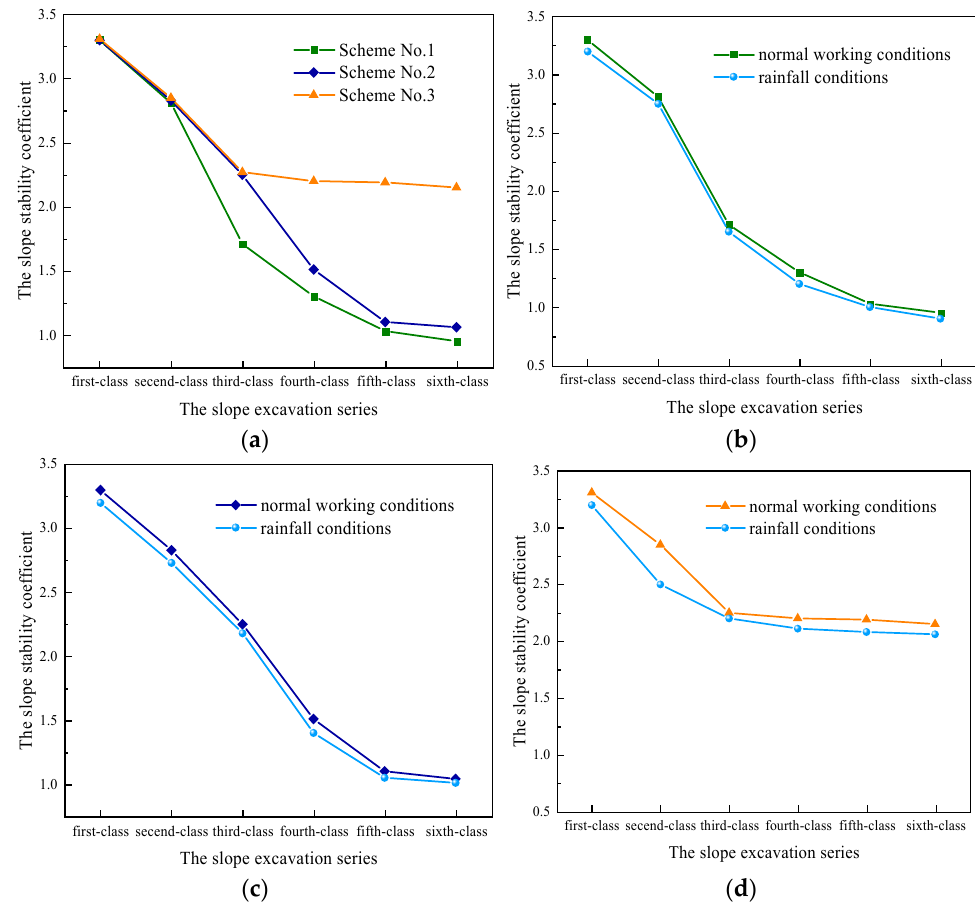
Figure 5. Slope stability factor. ( a ) Slope stability coefficient under normal conditions of different excavation schemes; ( b ) Scheme No.1 slope stability coefficient under different working conditions; ( c ) Scheme No.2 slope stability coefficient under different working conditions; ( d ) Scheme No.3 slope stability coefficient under different working conditions.